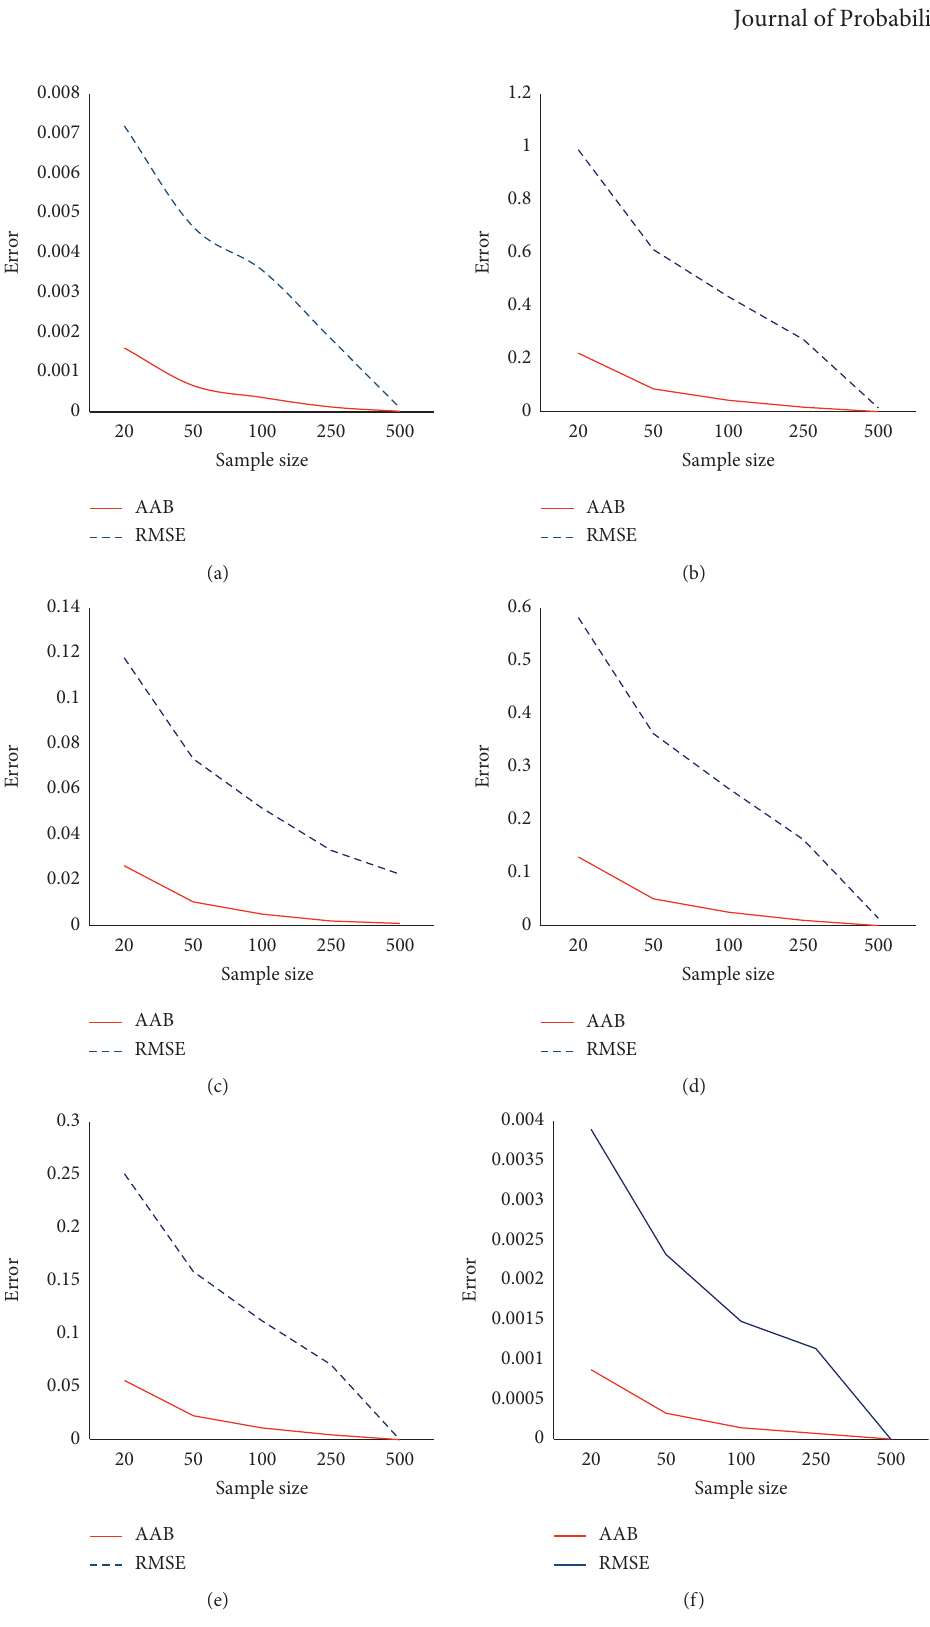
Figure 3: (a) α � 1.5. (b) β � 0.1. (c) c � 2.0. (d) ϕ � 0.3. (e) q � 0.01. (f) u �